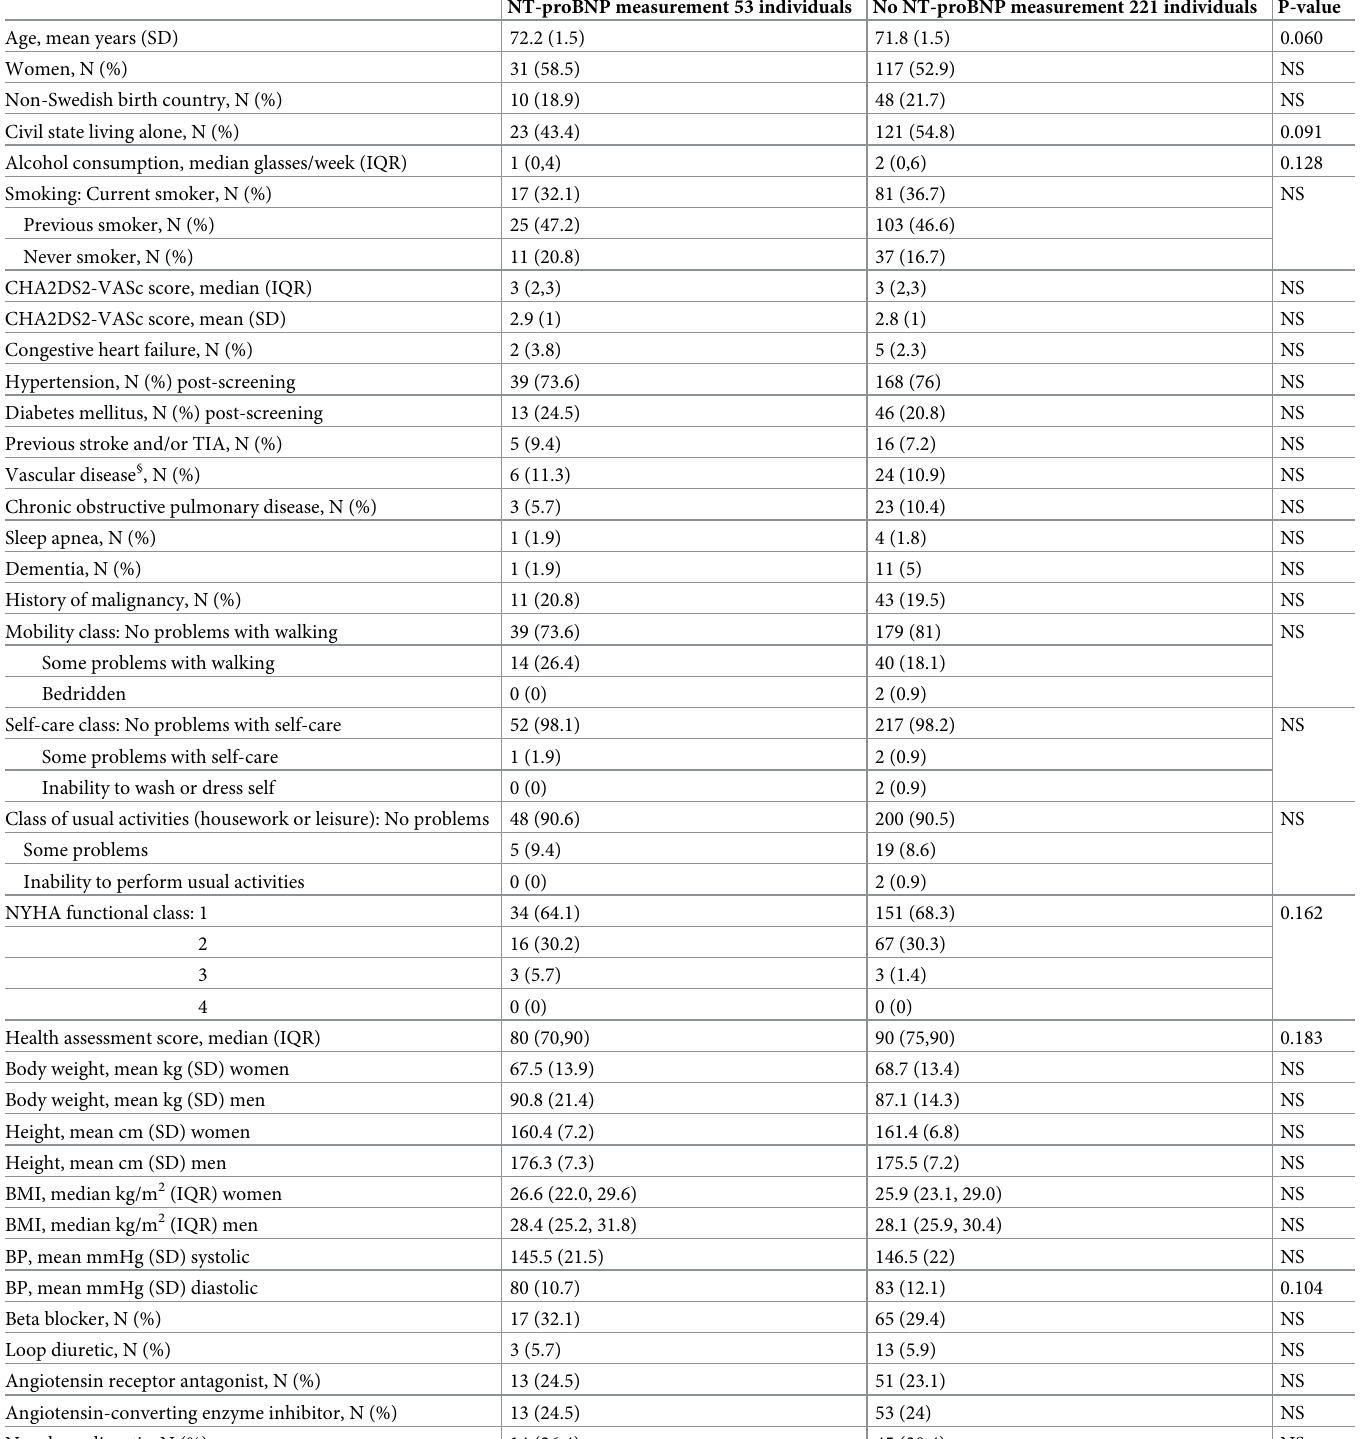
Table 1. Comparison between individuals with no detected AF who were assessed for NT-proBNP and individuals with no detected AF who were not assessed for